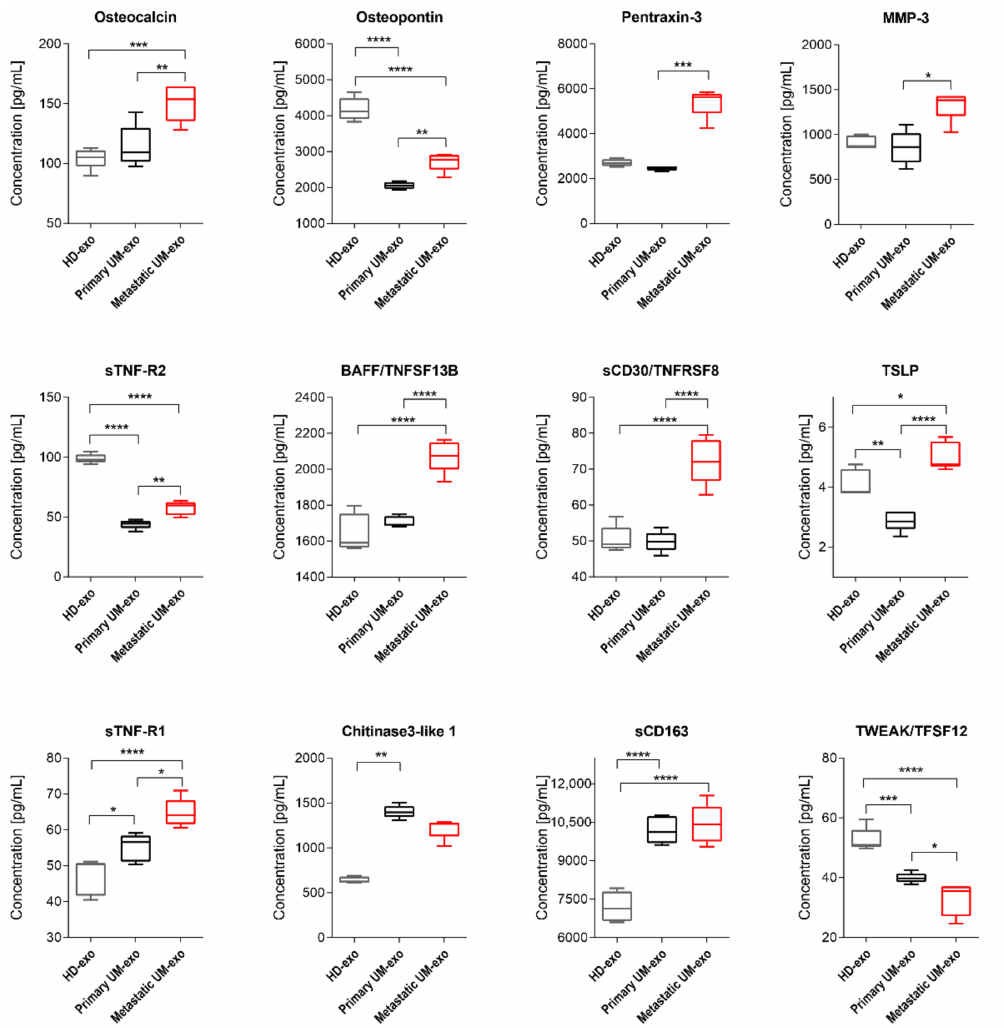
Figure 5. Box and whiskers plots presenting concentration of TNF superfamily, extracellular matrix and its modifying proteins in exosomes derived from healthy donors, primary and metastatic UM patients. Results are displayed as a median concentration in picograms per milliliter. Box and whiskers were calculated using the Tukey method. * p < 0.05, ** p < 0.01, *** p < 0.001, **** p > 0.0001: based on One-way ANOVA or Kruskal–Wallis test with Dunn’s post hoc multiple comparison